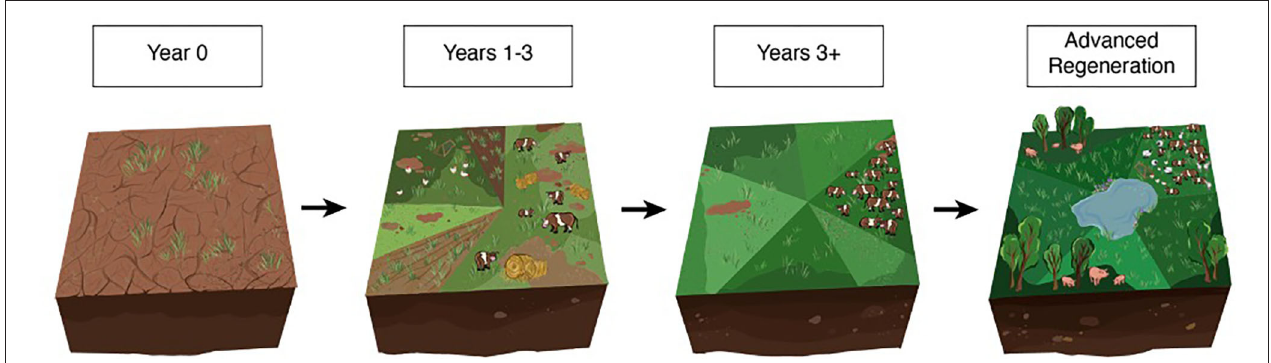
FIGURE 1 | The regeneration process employed by White Oak Pastures. Year 0: Degraded cropland is acquired; Years 1–3: Hay is fed to cattle grouped in moderate densities, compost is applied, grass is seeded, and cattle and poultry are grazed at low stock densities; Years 3 + : Animal stock densities are increased (25 to 50Mg ha − 1 daily), and holistic planned grazing (HPG) is implemented, where animals are rotated often and land is rested between grazing events; Advanced Regeneration: Represents a regenerative landscape (no seedings, added hay or compost since year 3) including rotations of diverse animal species with improved soil health and water